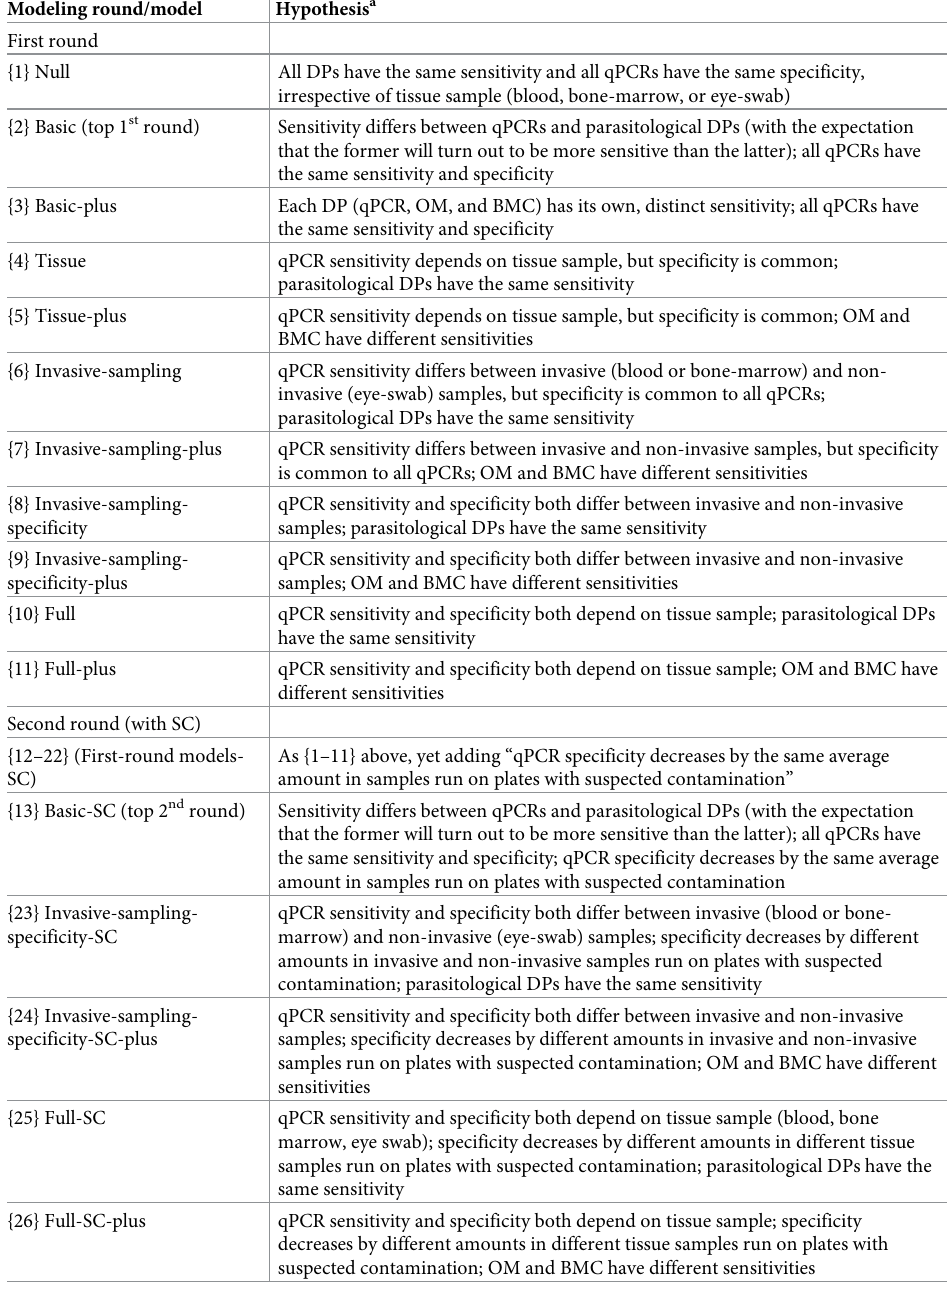
Table 2. Performance of parasitological and molecular diagnostic procedures (DPs) for detecting Leishmania infection in dogs: Models and associated